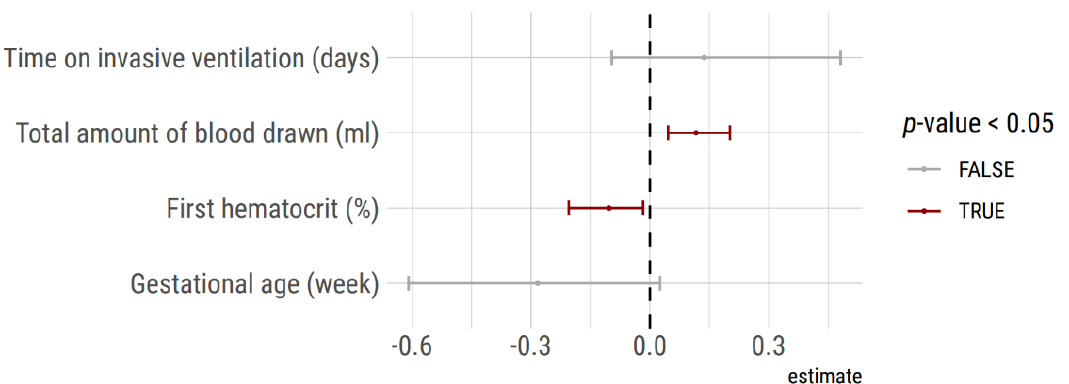
Figure 5. Predictors of transfusion deduced from a generalized logistic model. Cumulative blood sampling volume and hematocrit on admission were significant independent predictors of red blood cell transfusion during the hospital stay in the 132 VLBW included neonates into the analysis.